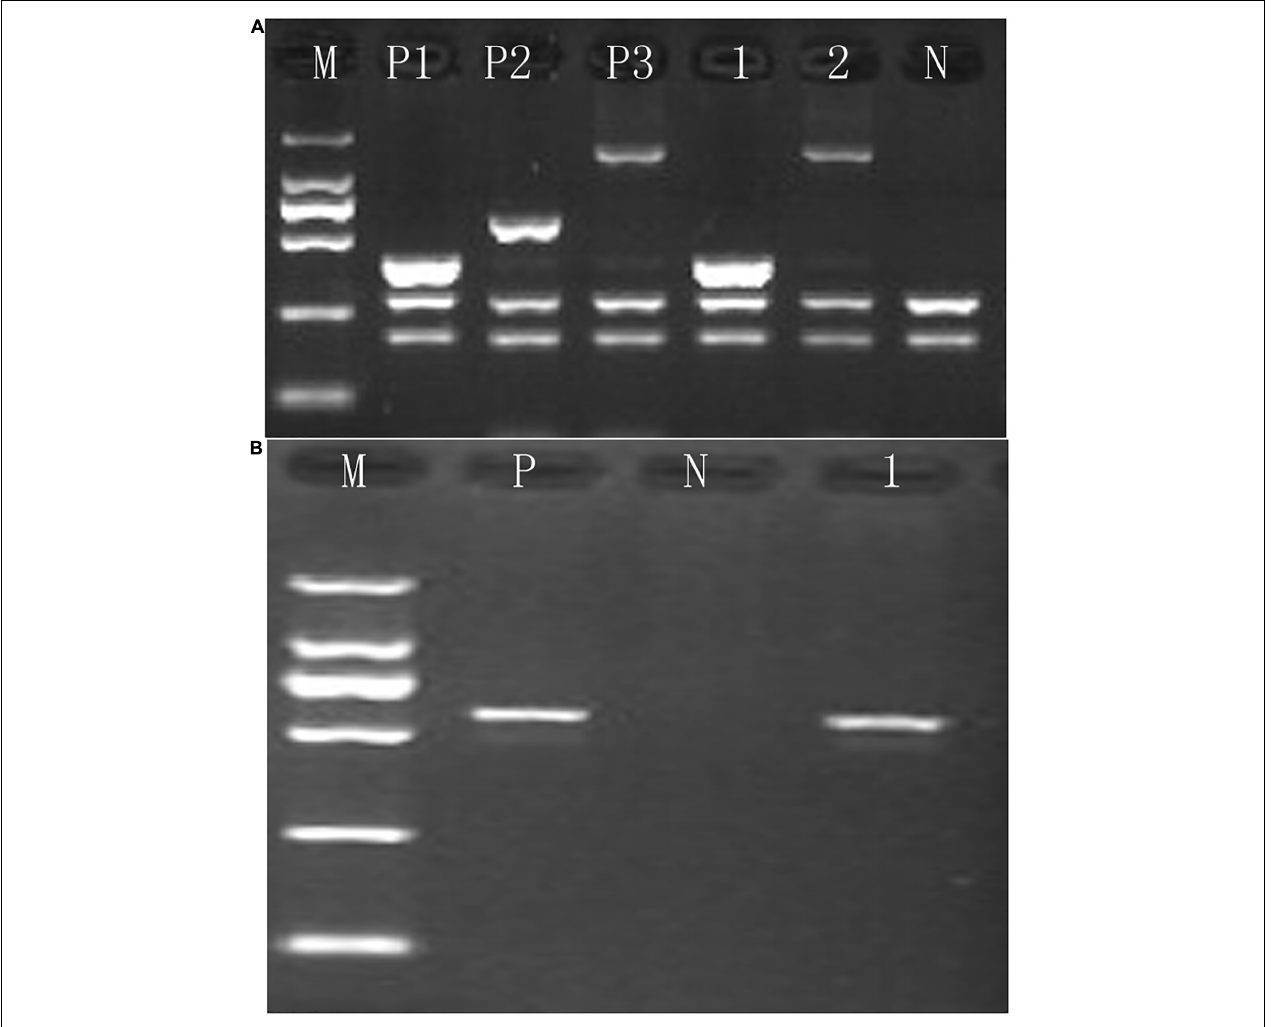
FIGURE 1 | Identification of rare α -thalassemia using gap-PCR. (A) Electrophoresis result of – THAI / αα and – α 27 . 6 / αα thalassemia; M, maker; P1, positive control of – THAI / αα ; P2, positive control of – α 21 . 9 / αα ; P3, positive control of – α 27 . 6 / αα ; N, negative control; 1, – THAI thalassemia carrier; 2, – α 27 . 6 thalassemia carrier. (B) Electrophoresis result of – FIL / αα thalassemia; M, maker; P, positive control of – FIL / αα ; N, negative control; 1, – FIL / αα thalassemia